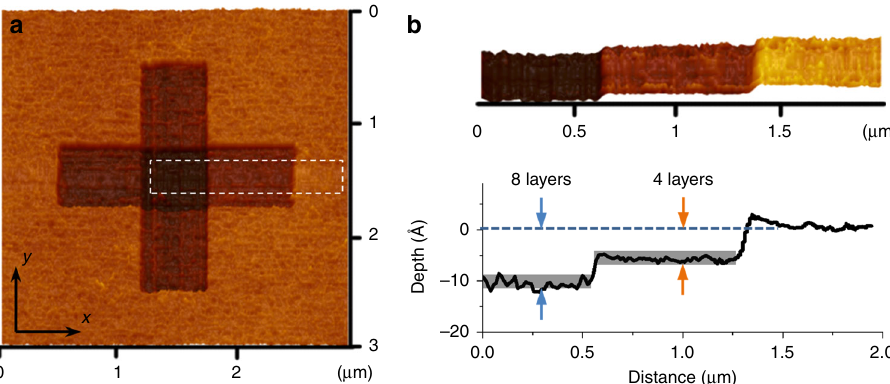
Fig. 4 Multilayer removals of silicon atoms by scan manufacturing. a SPM image of the manufacturing area. b 3-D topography and the cross-section pro fi le of the atomic multi-step in a . The load is 1 μ N and sliding speed is 4 μ m s -1 . In a , the fi rst scan was along the horizontal direction (64 lines in 0.5 μ m increment along y -axis) and the second scan was along the vertical direction (64 lines in 0.5 μ m increment along